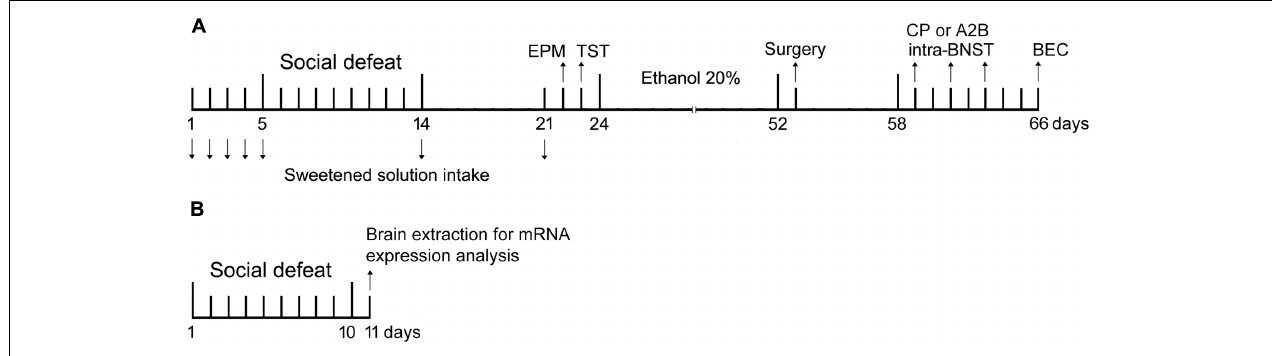
FIGURE 1 | Experiment design. (A) Timeline refers to behavioral analysis and blood ethanol concentration (BEC) in non-stressed controls and socially defeated mice. On day 1, mice were exposed to sweet solution two-bottle choice for 24 h (habituation). On days 2–4 (baseline intake), 5, 14, and 21 mice were offered sweet solution in the two-bottle choice procedure for 90 min. On days 5–14, stressed mice were weighed and socially defeated. Controls were weighed daily. On day 22, controls and socially defeated mice were tested in the elevated plus-maze (EPM), and next day in the tail suspension test (TST). On day 24, mice were given continuous access to ethanol and water for 4 weeks before the surgical procedure to implant cannulae into the bed nucleus of the stria terminalis (BNST). After recovery, mice were infused with selective CRF receptors antagonists (CP376,395 or astressin2B) and tested for alcohol drinking. Each mouse received three microinjections, with a 48-h interval between them, in a design that counterbalanced saline and drug treatments. On day 66, mice were euthanized and had the brains and blood samples collected for histological and BEC analysis. (B) Timeline refers to analysis of CRF, CRFR1 and CRFR2 mRNA expression in the BNST in non-stressed controls and socially defeated mice. On days 1–10, controls were weighed daily and stressed mice were weighed and socially defeated. On day 11, mice were euthanized and had the brains collected for mRNA expression